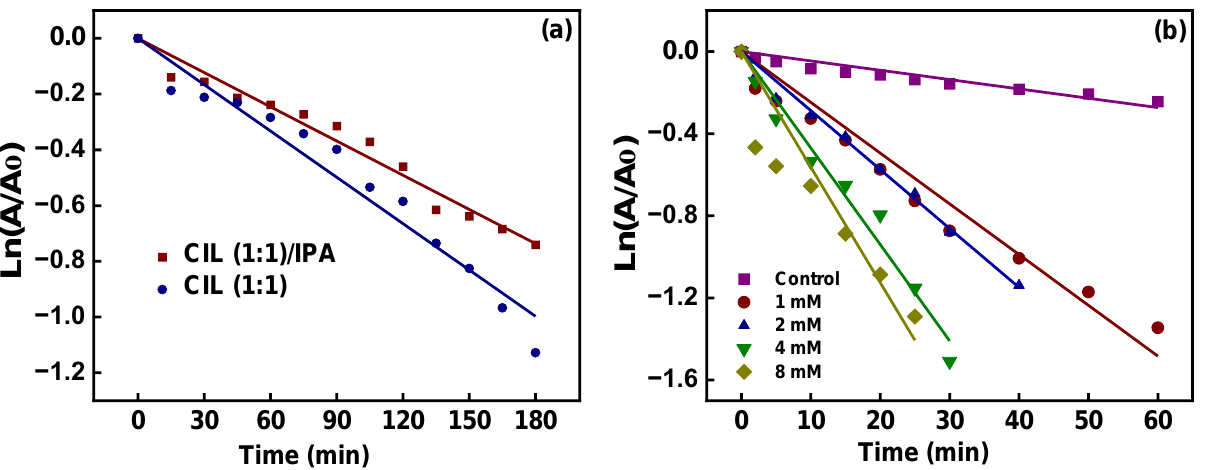
Figure 13. ( a ) Effect of IPA and ( b ) effect of persulfate concentration on photocatalytic activity. The effect of persulfate ions on the degradation of MB was studied varying the concentration of persulfate ions as 1, 2, 4 and 8 mM (Figure 13b). It was noted that the rate constant dramatically increased in the presence of persulfate ions in general, and the rate constant increased 5.4-, 6.3-, 10.3- and 12.4-fold, respectively, utilizing the abovementioned concentrations. Table 7 shows the increase in the rate constants with increasing concentrations of persulfate. Table 7. Variations in the pseudo-first-order rate constant by increasing the concentration of persul- fate ions.